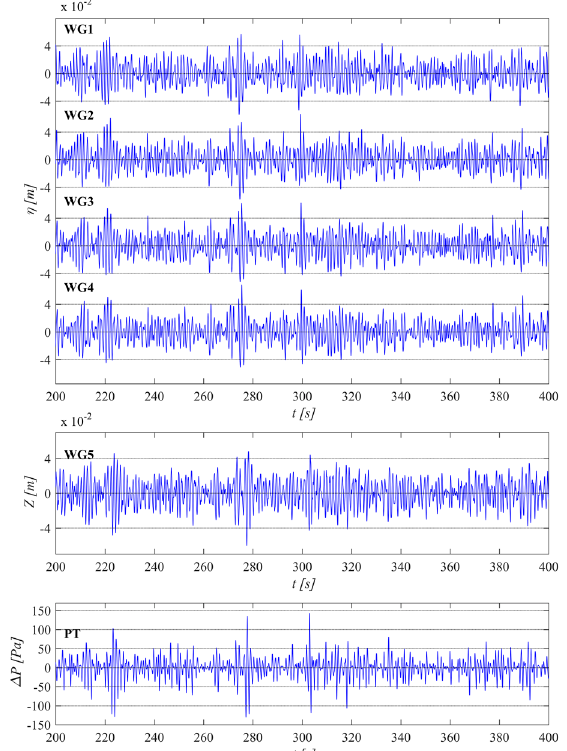
Figure 5. Recorded data, during part of a test, from the free surface elevations along the flume, the oscillation of the water column and the differential pressure between the inner OWC chamber and the atmosphere ( H S = 3.5 m, T P = 9.33 s, B * = 47.87).